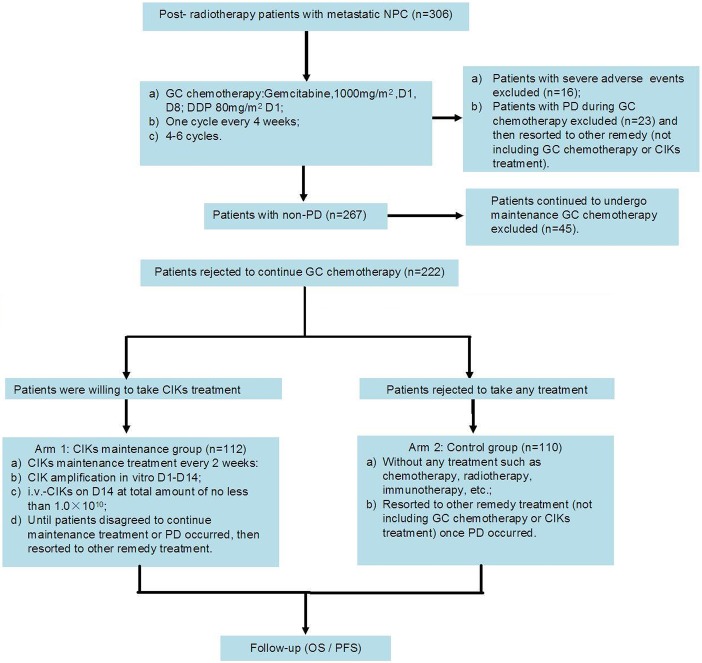
Study flow diagram.